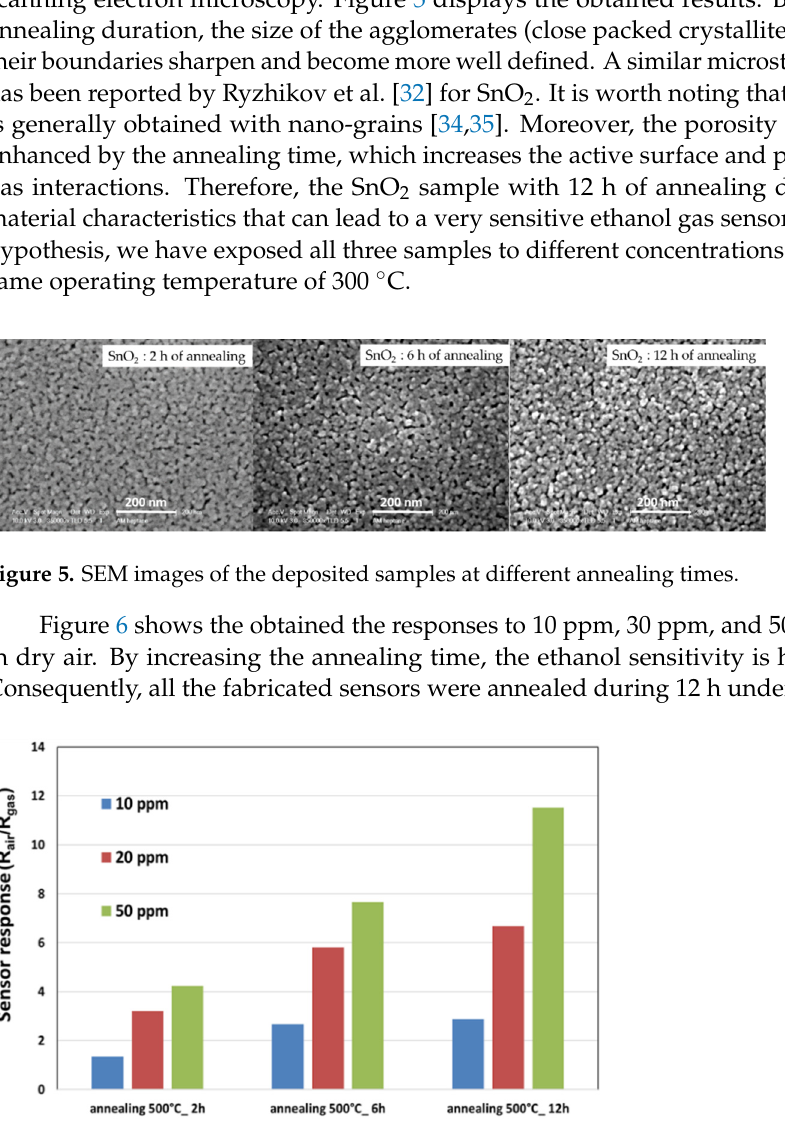
Figure 6 . A comparison between the responses of sensors annealed for 2, 6, and 12 h and their exposure to different concentrations of ethanol.